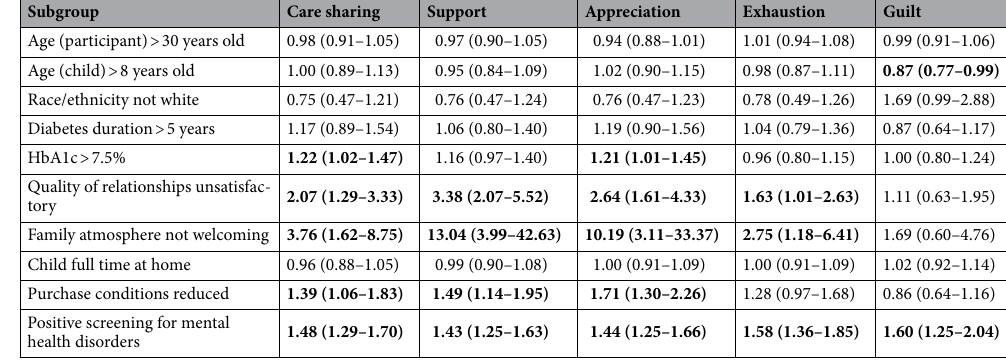
Table 3. Subgroup analysis to assess predictors of risk of diabetes-specific emotional burden during the COVID-19 pandemic among guardians of children and adolescents with type 1 diabetes. Data are odds ratio (OR) and 95% CI and represent the likelihood of subgroups of interest present diabetes-specific emotional burden in the respective domains related to the diabetes care. For each subgroup, the OR was calculated for the subgroup of interest versus the opposite group (eg, family atmosphere not welcoming vs. welcoming). Only participants of diabetes group were included. In bold, the subgroups that presented significantly higher (> 1.00) or lower (< 1.00) likelihood for presenting diabetes-specific emotional burden in the respective domain in relation to the opposite